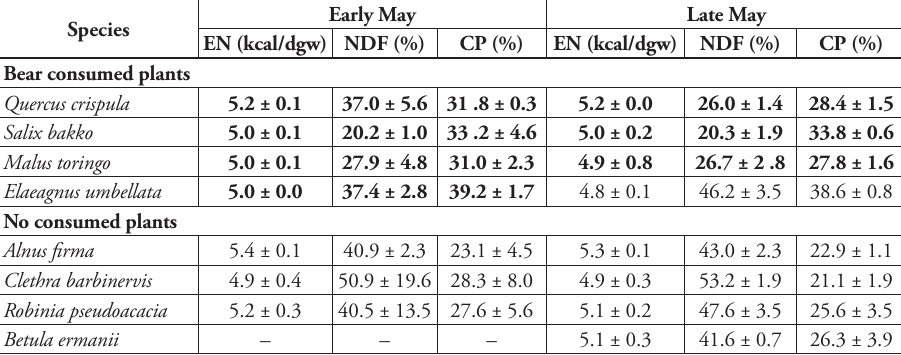
Table 1. Nutritional contents of tree leaves in early and late May.